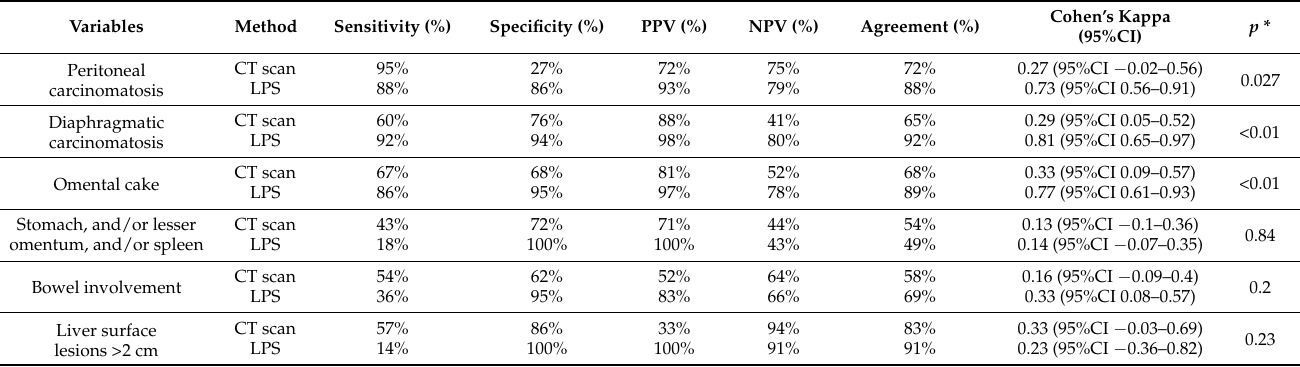
Table 2. Concordance between predictive index (PI) scores at computed tomography (CT) scan and laparoscopy (LPS) in women who underwent primary debulking surgery. PPV: positive predictive value; NPV: negative predictive